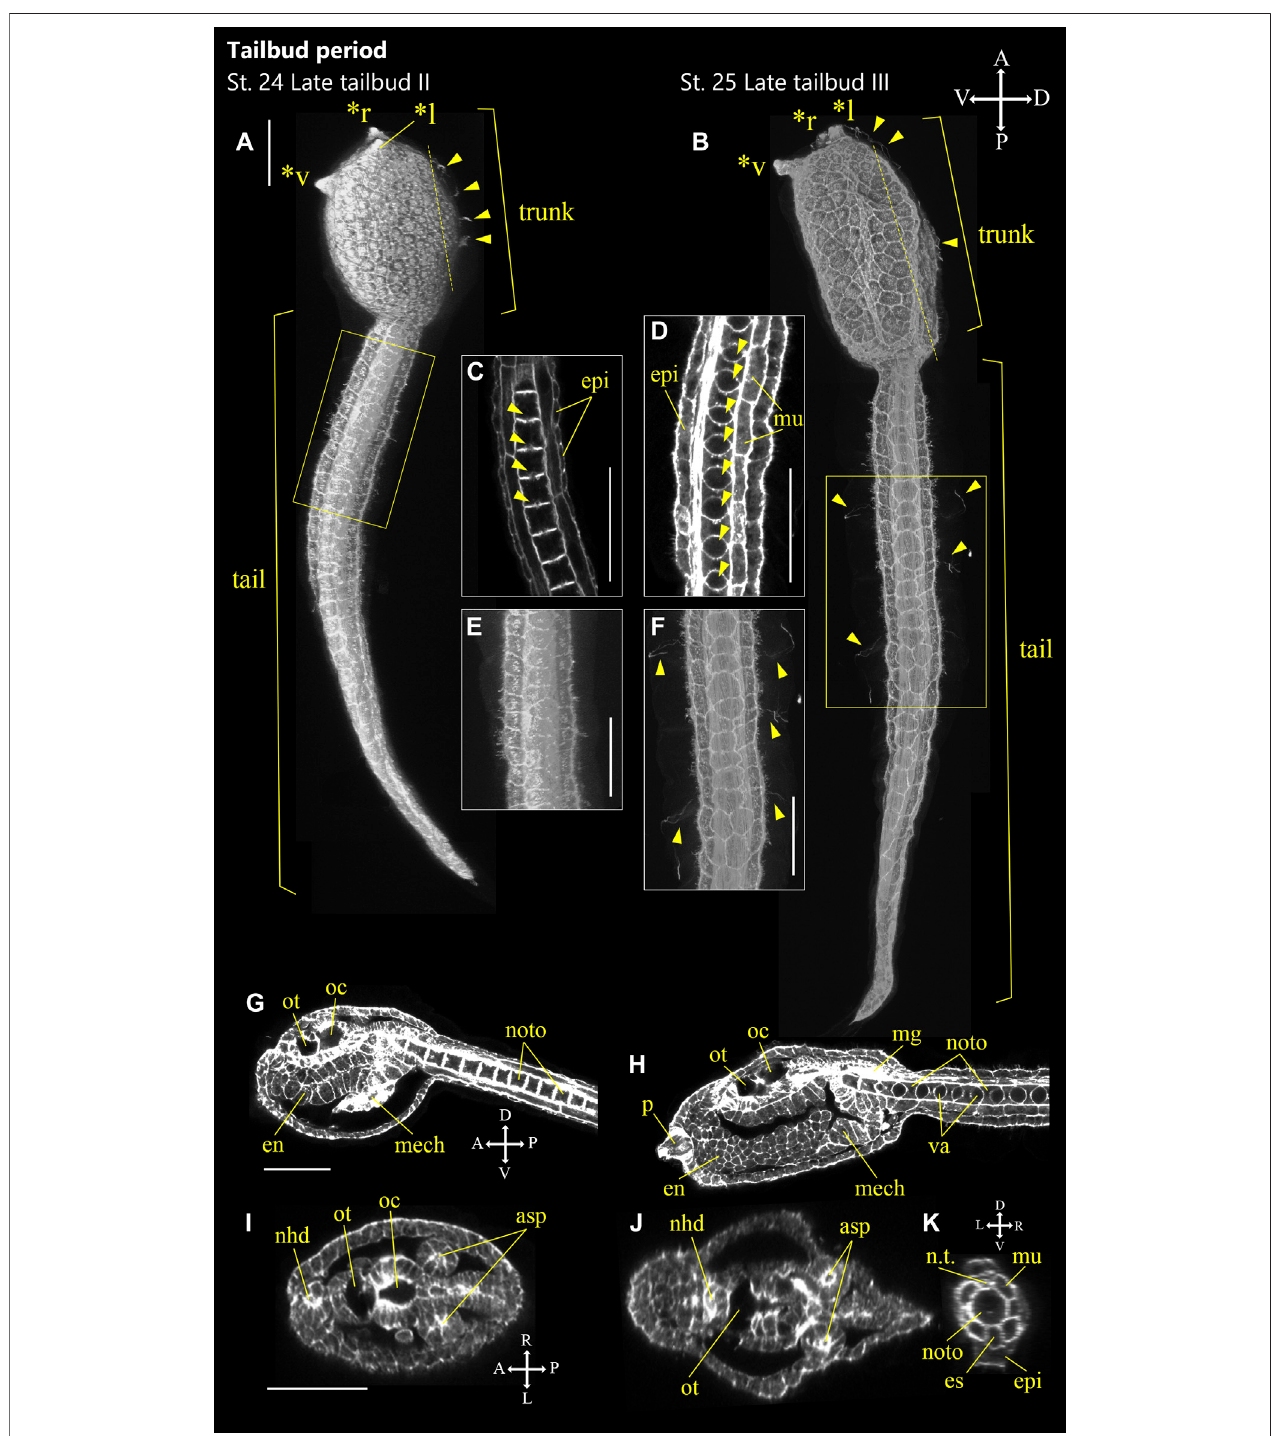
FIGURE 7 | Ascidiella aspersa embryos at the latter of tailbud period. Embryos were stained with Alexa Fluor ™ 54 Phalloidin. Three-dimensional reconstructed imagesat (A) Stage24(late tailbud II) and (B) Stage25(late tailbud III). (A,B) showthe lateralviewsofthe embryos. (C,D) Enlargedlongitudinalsection ofthearea inside the yellow frame in (A,B) , respectively. Arrowheads indicate vacuoles in notochord cells. (E,F) Enlarged image of the area inside the yellow frame in (A,B) , respectively. (G,H) Longitudinal section of (A,B) , respectively. (I,J) Cross-section of the trunk. The positions of the sections are indicated by dashed lines in (A,B) . (K) Cross- section of the tail in (B) . Embryo direction is shown by A, anterior; P, posterior; D, dorsal; V, ventral. In (A,B, F) , arrowheads indicate the cilia of epidermal sensory neurons. Asterisks indicates the papillae by*l: left papilla, *r:right papilla, *v:ventral papilla. asp, atrial siphon primordium; en, endoderm; epi, epidermis;es, endodermal strand;mech: mesenchyme;mg, motorganglion;mu,muscle;nhd, neurohypophyseal duct; noto, notochord; n.t.,neural tube; oc,ocellus; ot,otolith; p,papilla; andva, vacuole. Scale bar: 50 μ m.